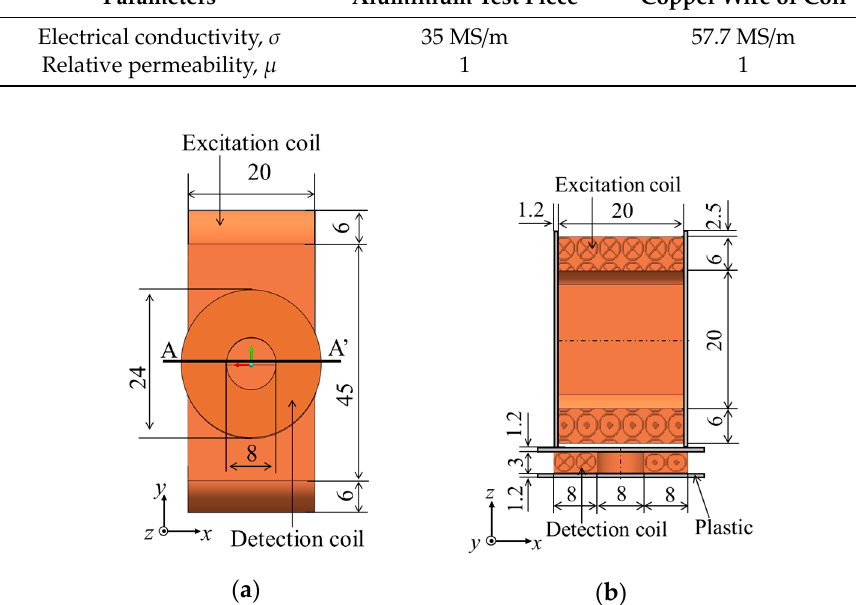
Figure 4. Coil structure of conventional uniform eddy current (UEC) probe (units in mm). The number of turns of an excitation coil is 2000: ( a ) bottom view; ( b ) section view of A-A’.